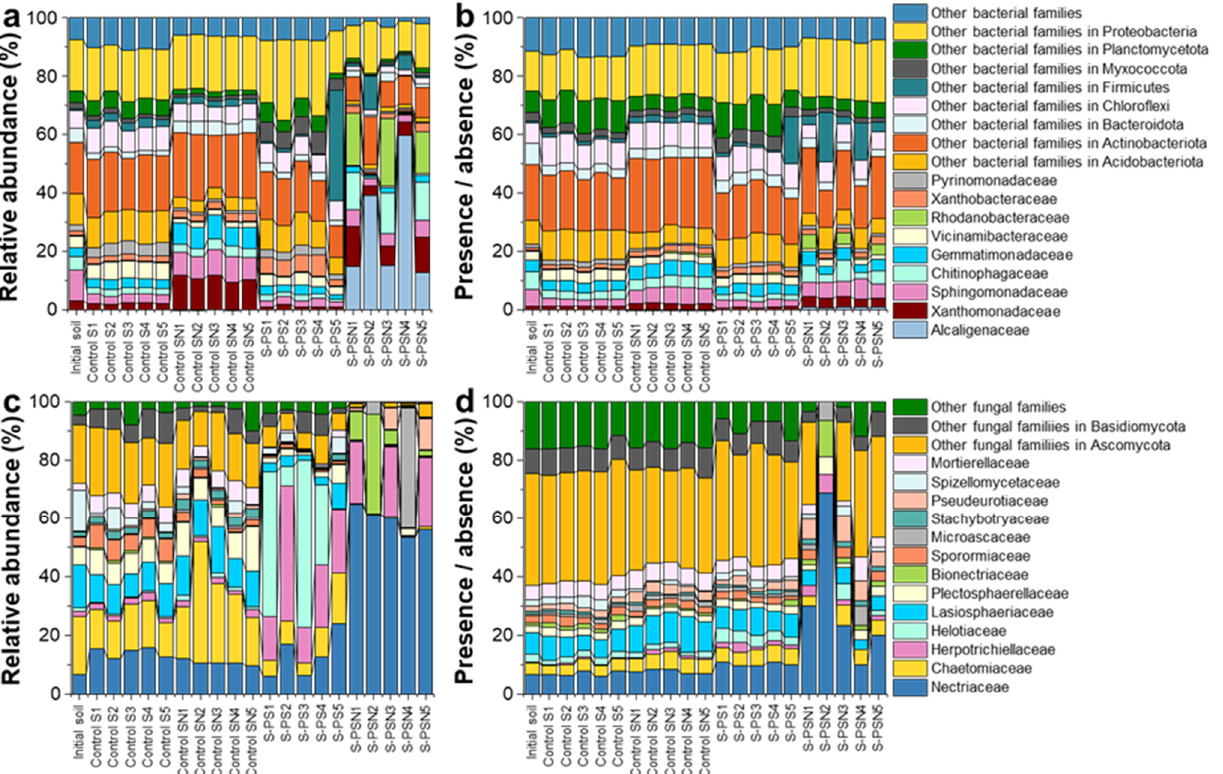
Figure 1. Composition of the bacterial ( a , b ) (family level, considering only families with relative abundances ≥ 2%, the rest of the bacterial families were pooled as “others”) and the fungal ( c , d ) (family level, considering only families with relative abundances ≥ 1%, the rest of the fungal families were pooled as “others”) communities associated with the degradation of a bio-based and biodegradable poly (butylene succinate-co-adipate) (PBSA) based on relative abundance (left panel, a , c ) and presence/absence data (right panel, b , d ). Data are presented for initial soil (initial S), control soils (control S), control soils with (NH4) 2 SO 4 addition (control SN), soils with PBSA addition (S–PS), and soils with PBSA and (NH4) 2 SO 4 addition (S–PSN).